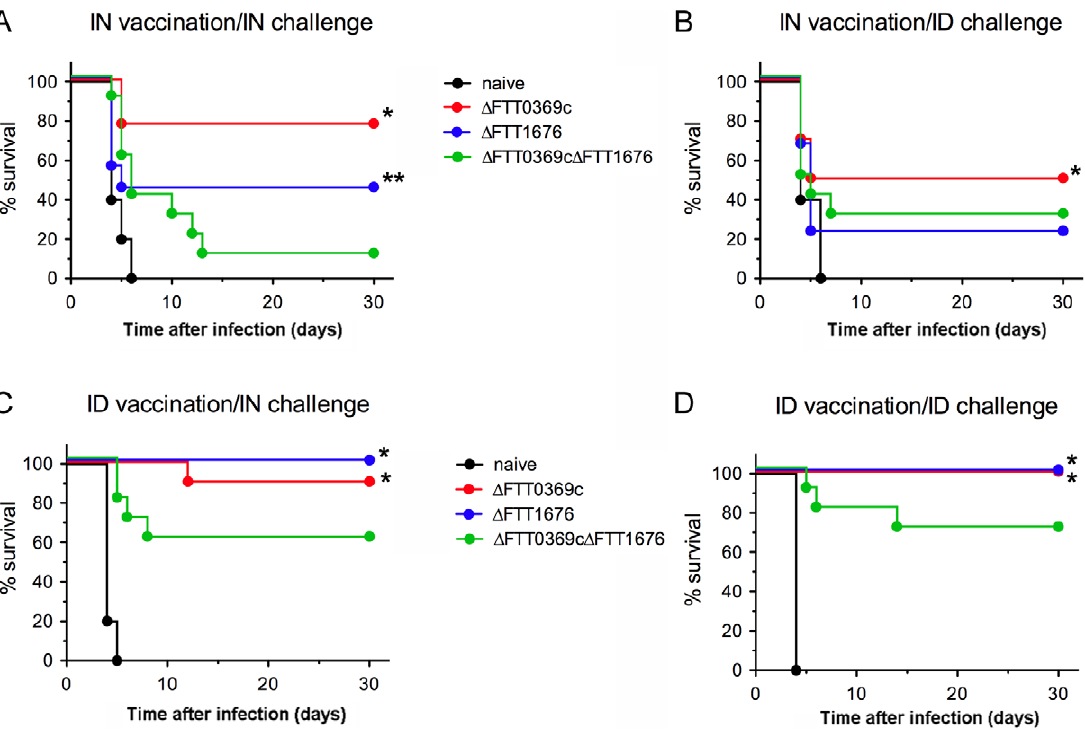
Figure 3. Protective capability of SchuS4 D FTT0369c, D FTT1676 and D FTT0369c D FTT1676 mutants against parenteral and pulmonary challenge with wild type SchuS4. Balb/c mice (n=10/group) were infected intradermally or intranasally with approximately 50 CFU or 10 CFU, respectively, of the indicated strains of F. tularensis SchuS4. Forty-five days after infection, mice were challenged with approximately 50 CFU or 10 CFU of wild type F. tularensis SchuS4 intradermally or intranasally, respectively. Mice were regularly monitored up to 30 days after infection and euthanized at the first sign of irreversible illness. Data are representative of 2 experiments of similar design. *=p , 0.05 compared to all other groups. **=p , 0.05 compared to naı¨ve animals and mice vaccinated with D FTT0369c D FTT1676.